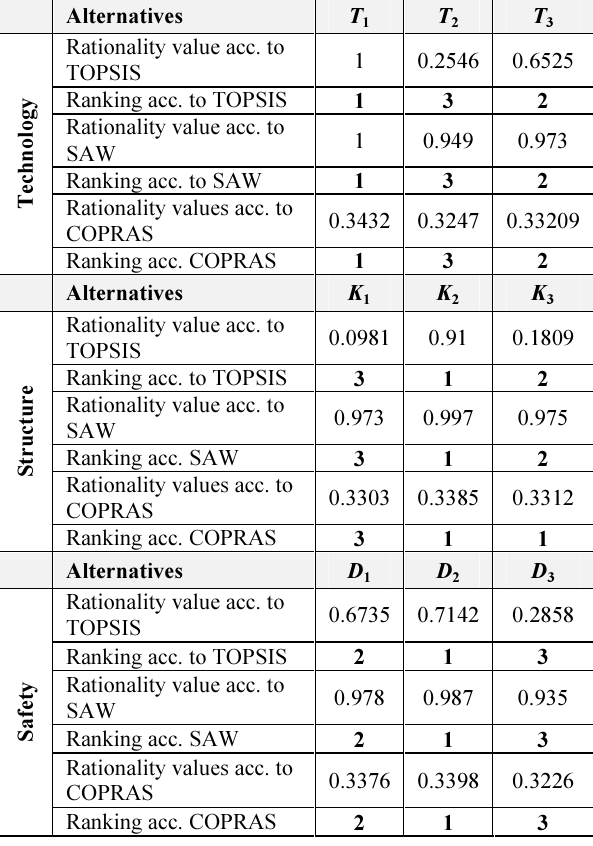
Table 5. Rationality indicators of structural, technological